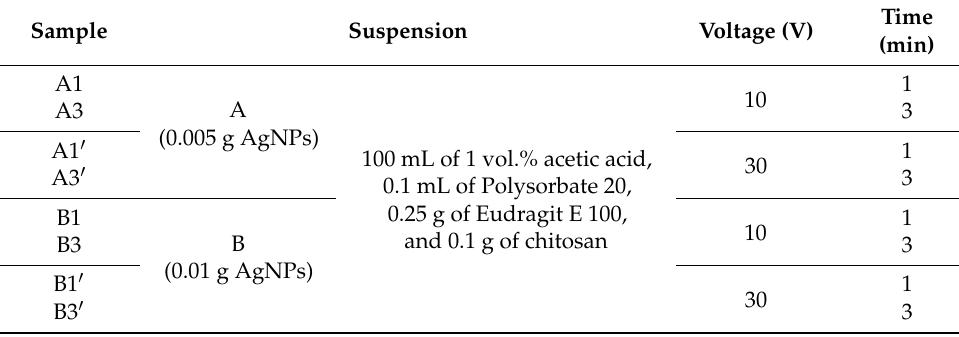
Table 2. Characteristics of the process parameters for particular test